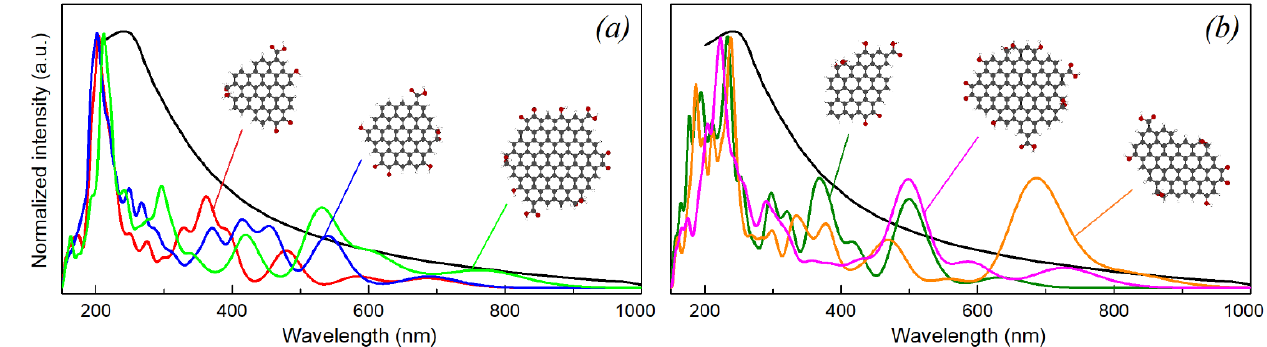
Figure 5. Comparison of experimental UV-Vis spectrum and the calculated absorption spectra of rGO fragments with high-symmetry ( a ) and low-symmetry polyaromatic core ( b ).